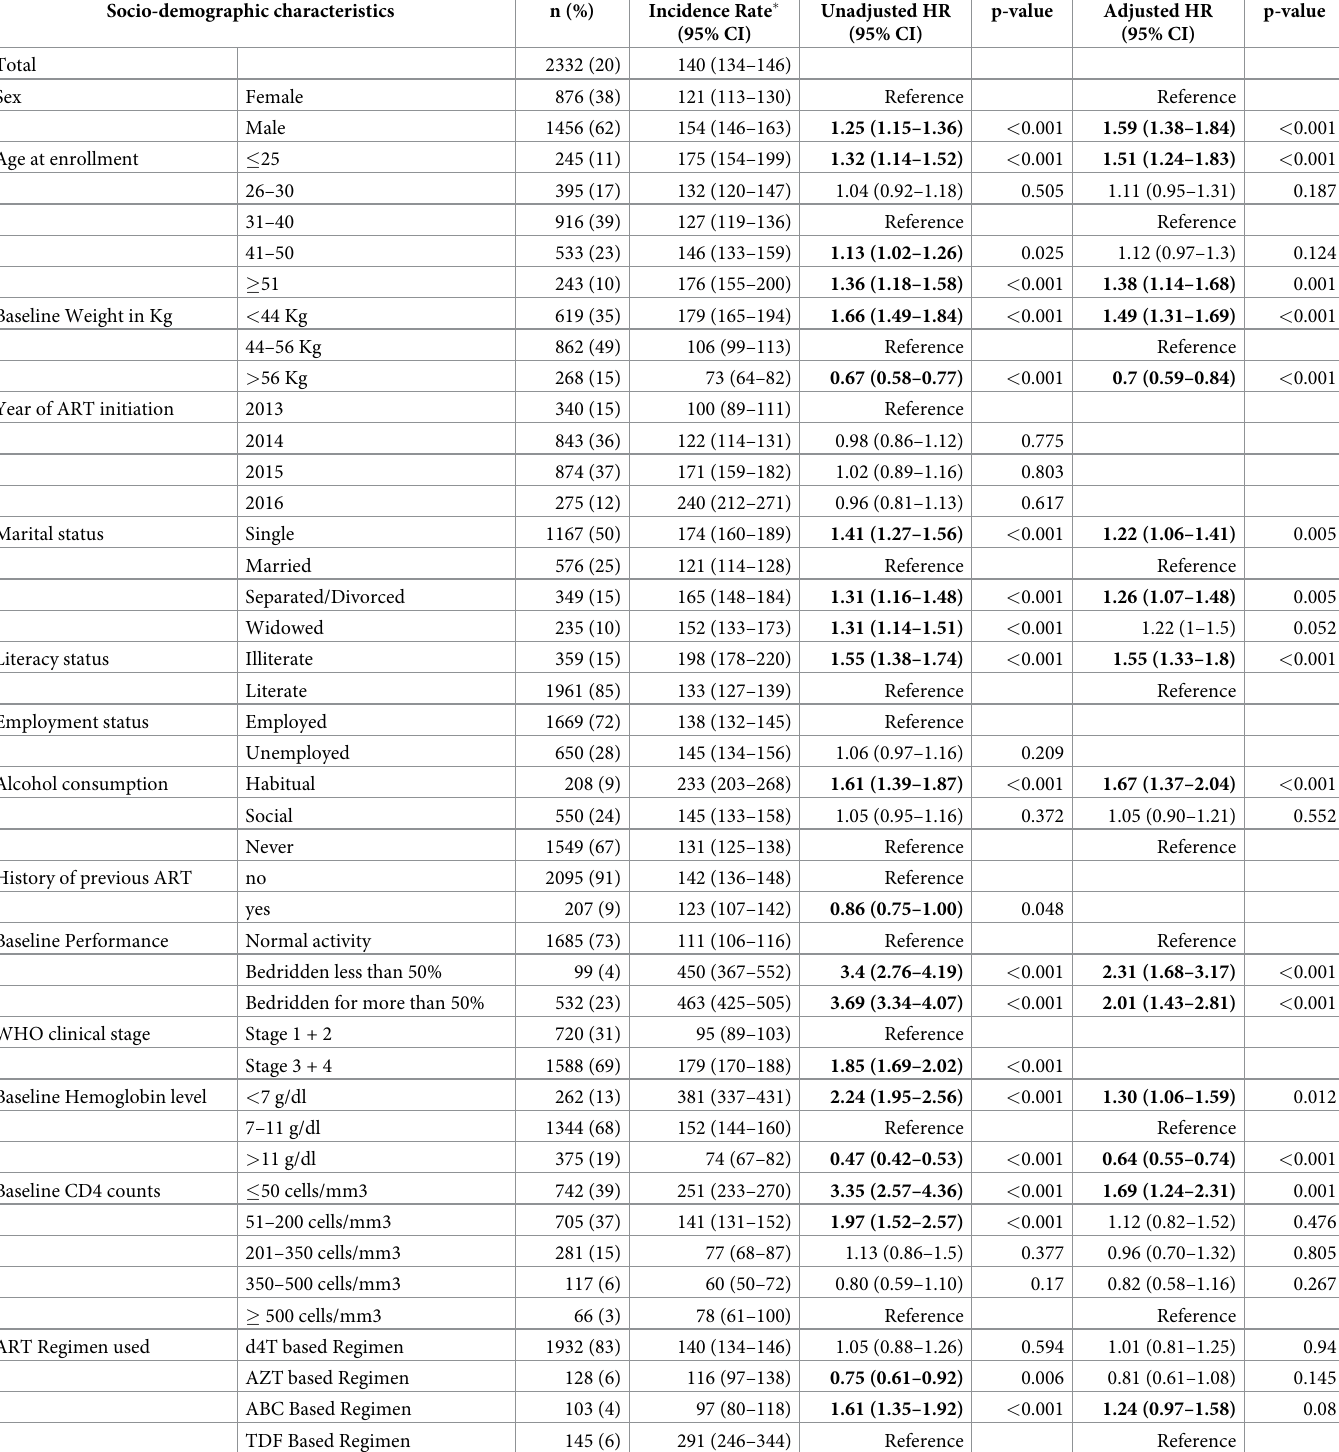
Table 3. Factors associated with attrition after ART initiation after ART initiation among people living with HIV who were enrolled in three hospitals specializing for HIV care in Yangon, Myanmar, 1 st June 2013 to 30 th June 2016. Socio-demographic